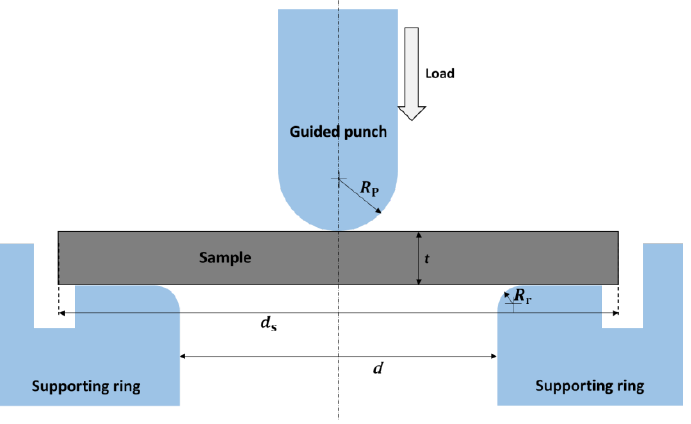
Figure 2. Schematic of the device used for small punch test.